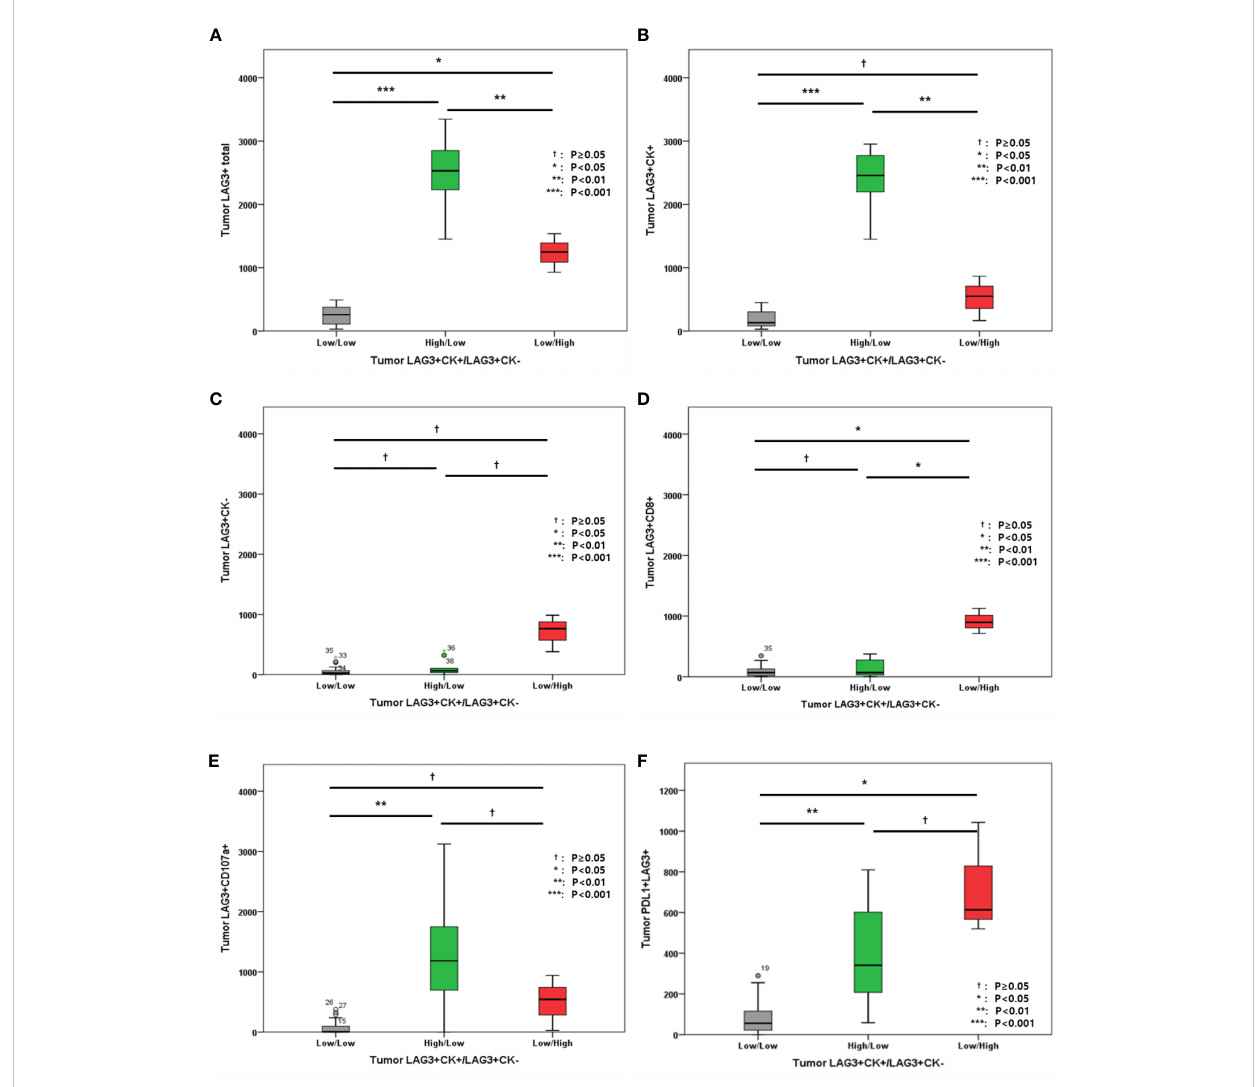
FIGURE 5 (A) Level of tumor LAG3+ cells; (B) Level of tumor LAG-3+CK+ cells; (C) Level of tumor LAG-3+CK- cells; (D) Level of tumor LAG-3+CD8+ cells; (E) Level of LAG-3+CD107a+ cells; (F) Level of PD-L1+LAG-3+ cells according to tumor LAG-3+CK+/LAG-3+CK-